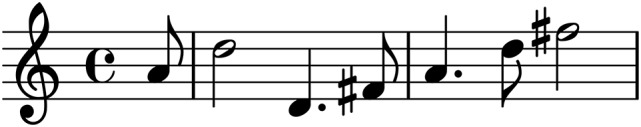
The Schwert-Motiv in D major.